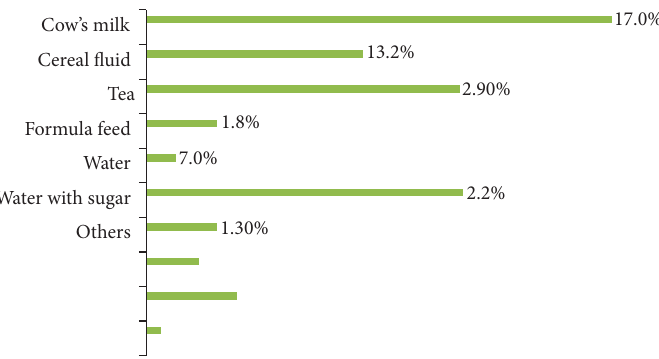
Figure 2: Mixing of breast milk with some foods among mothers in Debre Tabor